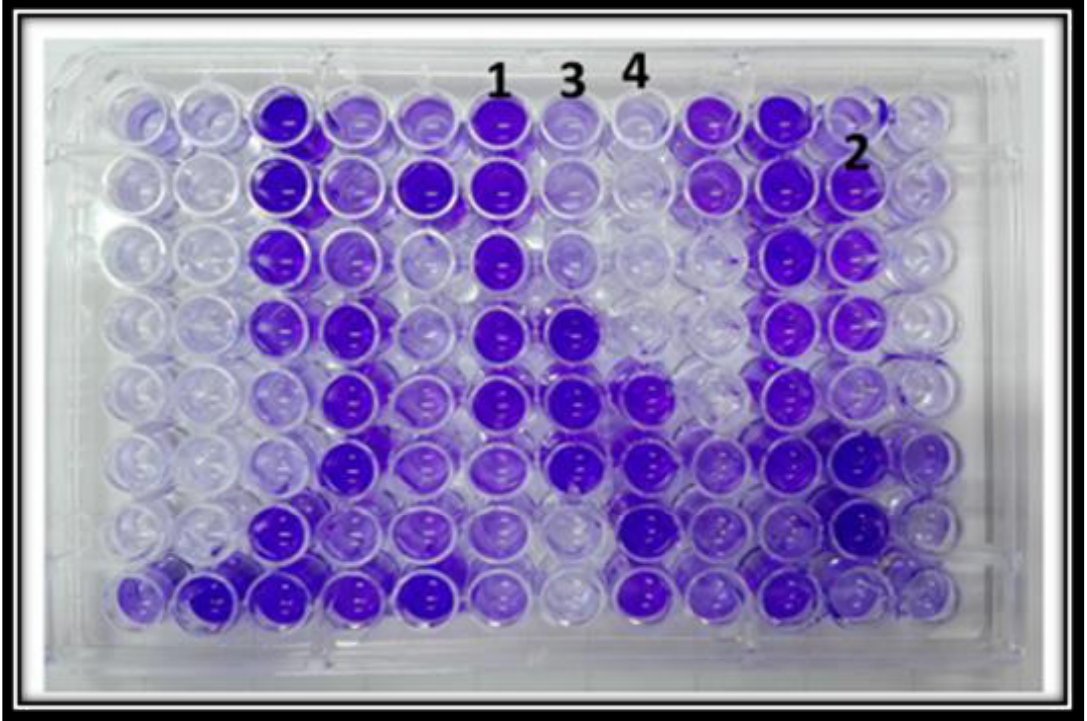
Figure 1. TCP showing; (1) Strong, (2) moderate, (3) weak biofilm producing strains, and (4) Non biofilm forming strain.